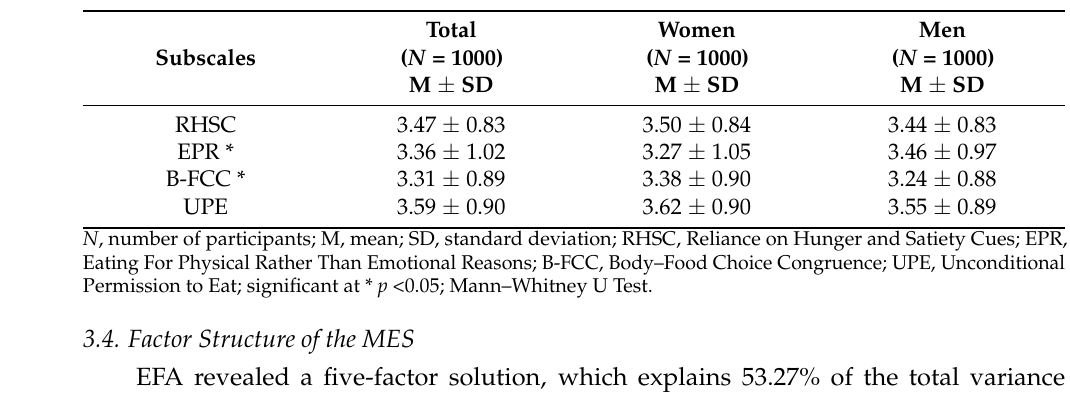
Table 5. Mean scores for IES-2 subscales.